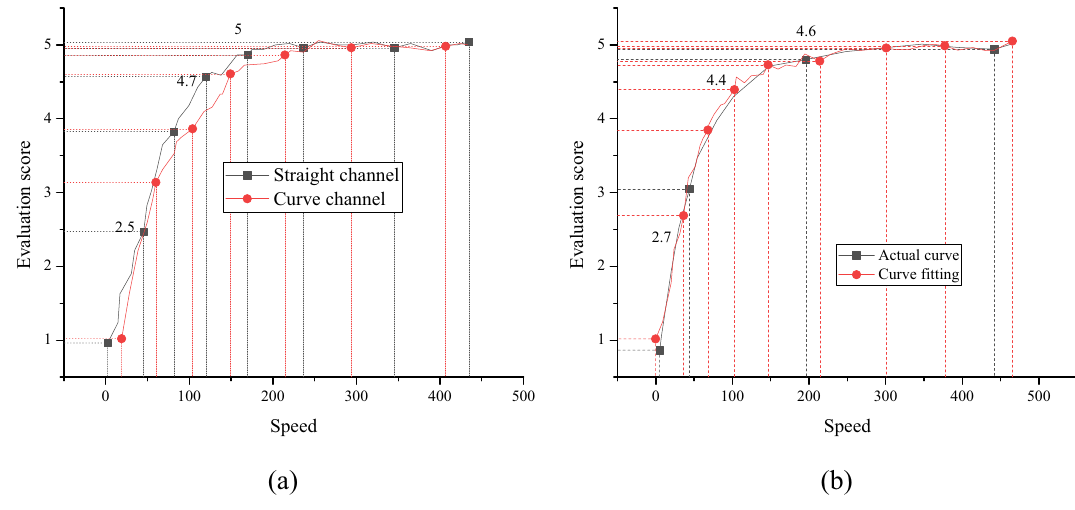
Fig. 5 Dizziness in the horizontal rotation motion scene ( a comparison results in the scene of the linear channel and curve channel, b curve fitting